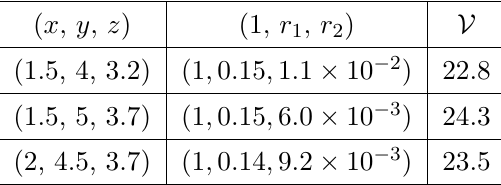
√ y (8 x + y ) and z = x , in 4